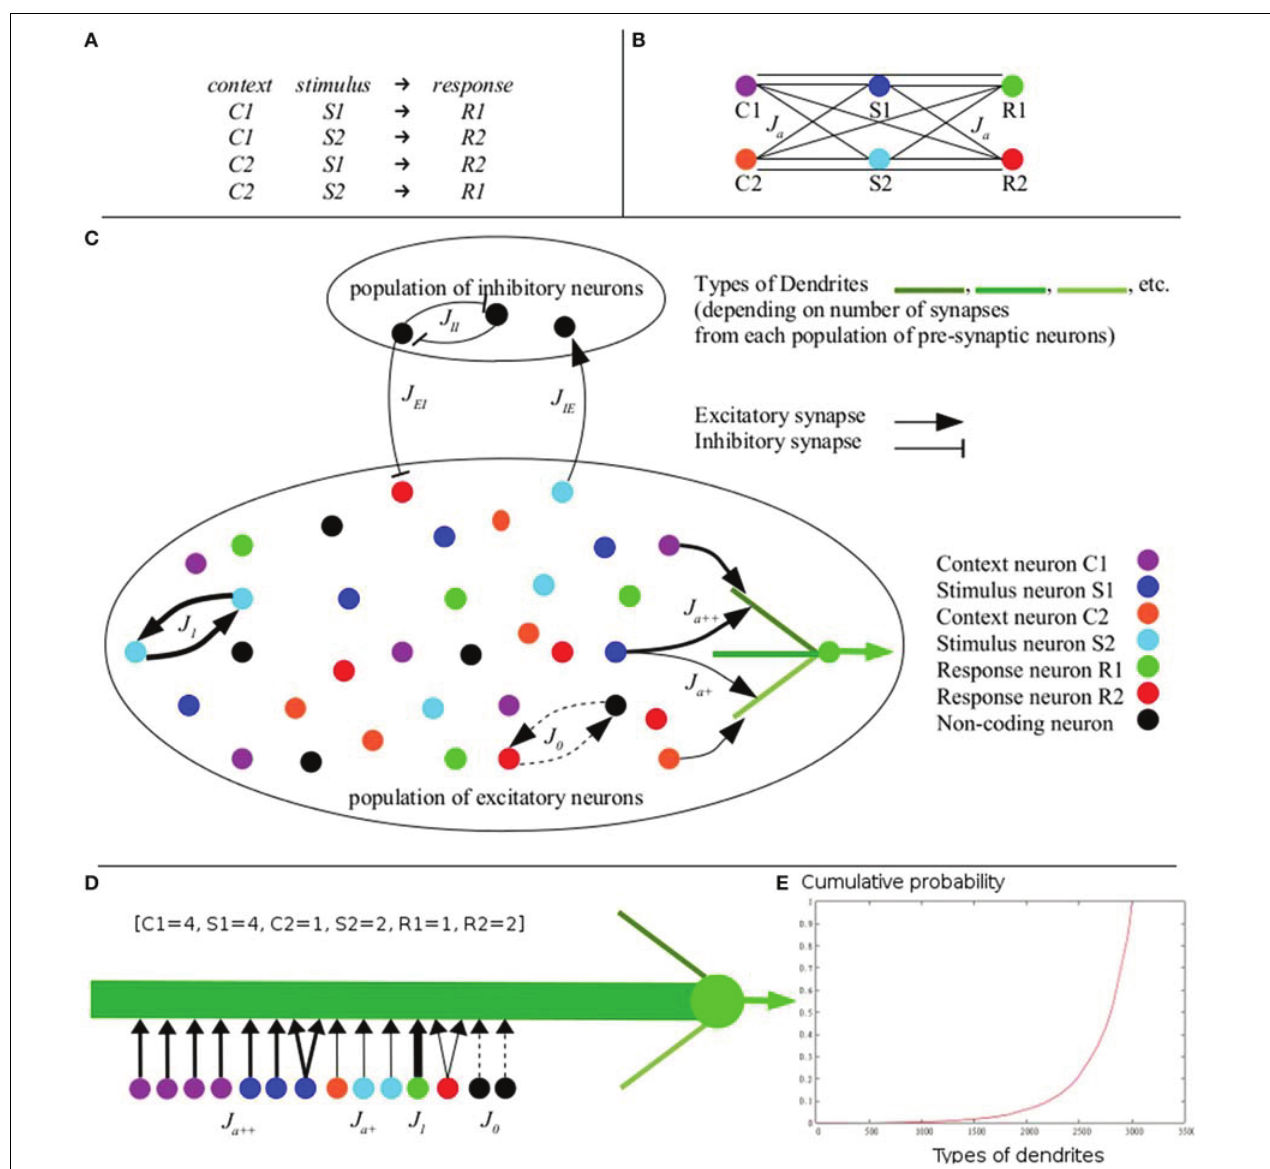
FIGURE 1 | The XOR-like combination rule. (A) A typical combination rule requires the subject to give a response to a combination of context and stimulus. Responses (R1 vs. R2) are predicted equally by each individual context (C1 vs. C2) and each individual stimulus (S1 vs. S2), making responses not linearly separable in the space of contexts and stimuli (Considering C1 = C2, S1 = S2, R1 = R2, this combination rule corresponds to a XOR rule). Responses can be discriminated only on the basis of the four combinations of one context and one stimulus. (B) Schematic representation of excitatory links between populations of neurons coding for the six items involved in the rule: stimuli S1 (dark blue) and S2 (light blue), contexts C1 (purple) and C2 (orange), and responses R1 (green) and R2 (red). Hebbian learning of the XOR-like rule generates equal efficacy between each context, each stimulus and each response (black lines). (C) Architecture and synaptic connectivity of the cortical network model embedding IS learning (for clarity, all connections are not displayed; see Table 1 for values of connectivity). Excitatory neurons are selective for distinct stimuli (same color codes as in B ). According to the IS learning algorithm, efficacy values (thickness of the arrows) depend on